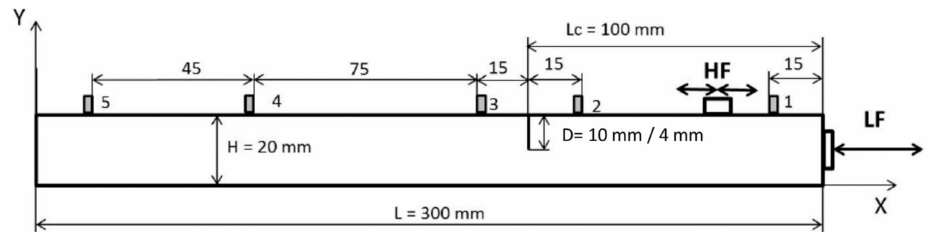
Figure 17. Schematic diagram indicating crack, actuator, and sensor positions.